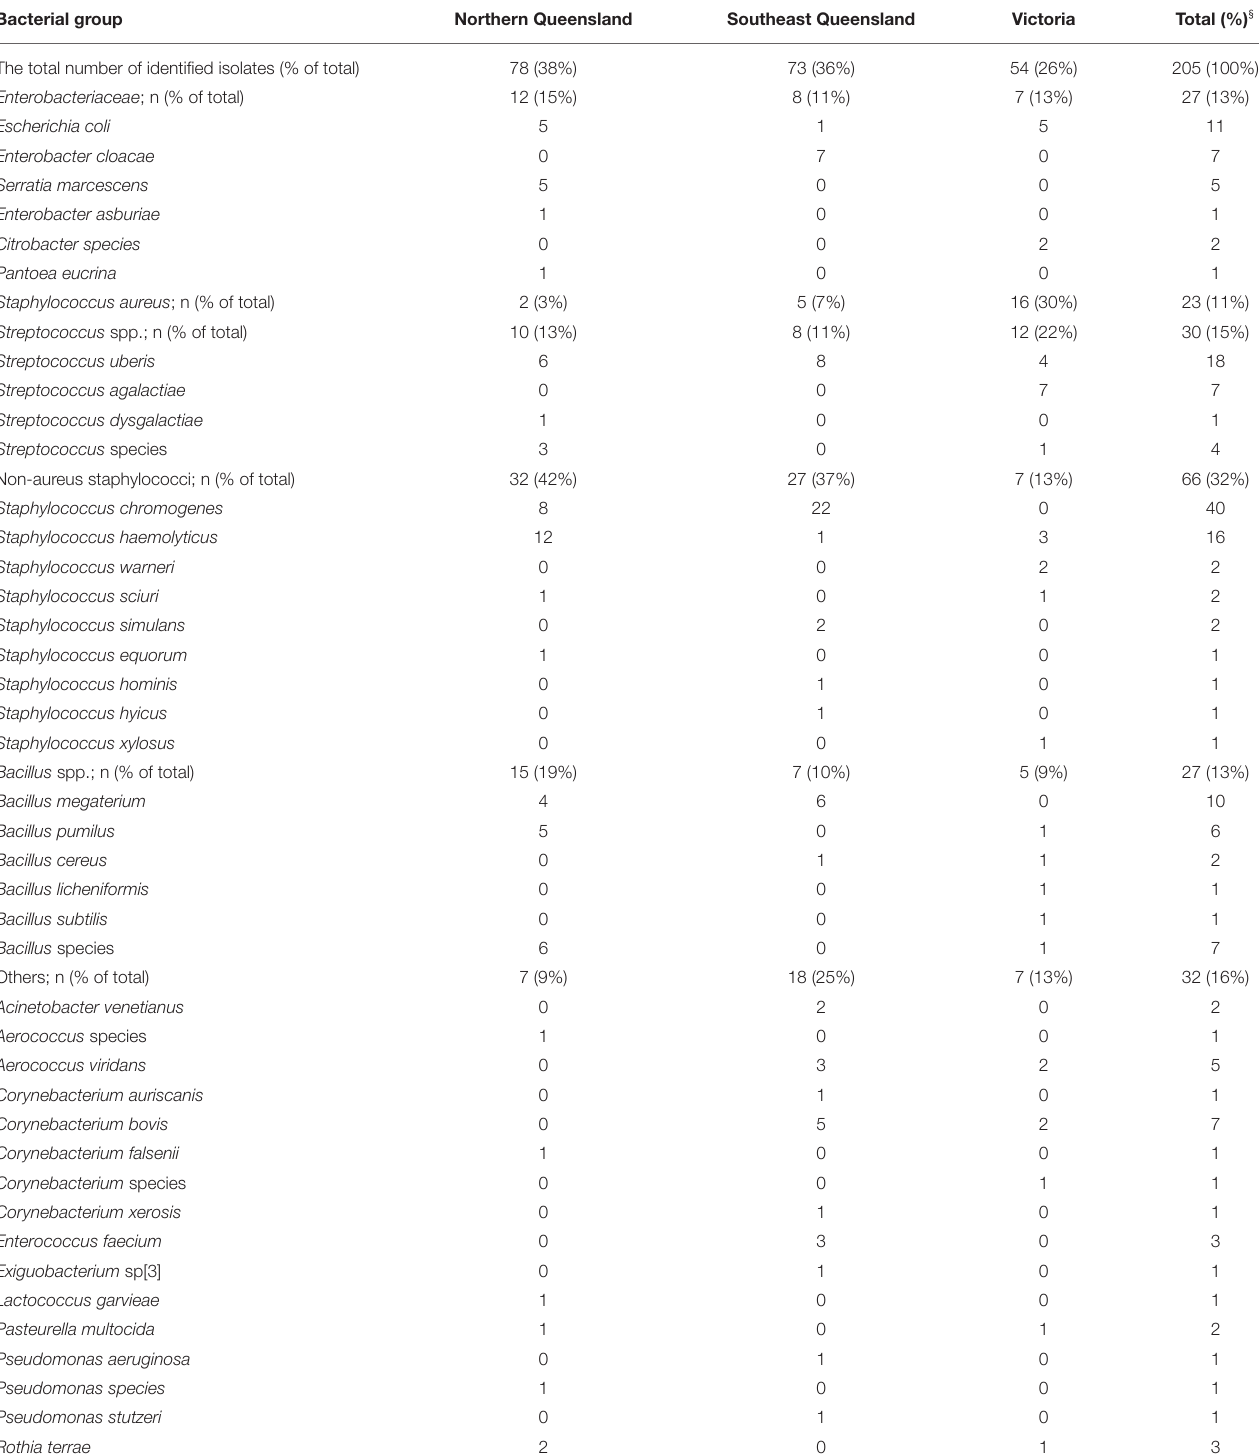
TABLE 2 | Distribution of the identified bacterial species by bacterial group and region. Bacterial group Northern Queensland Southeast Queensland